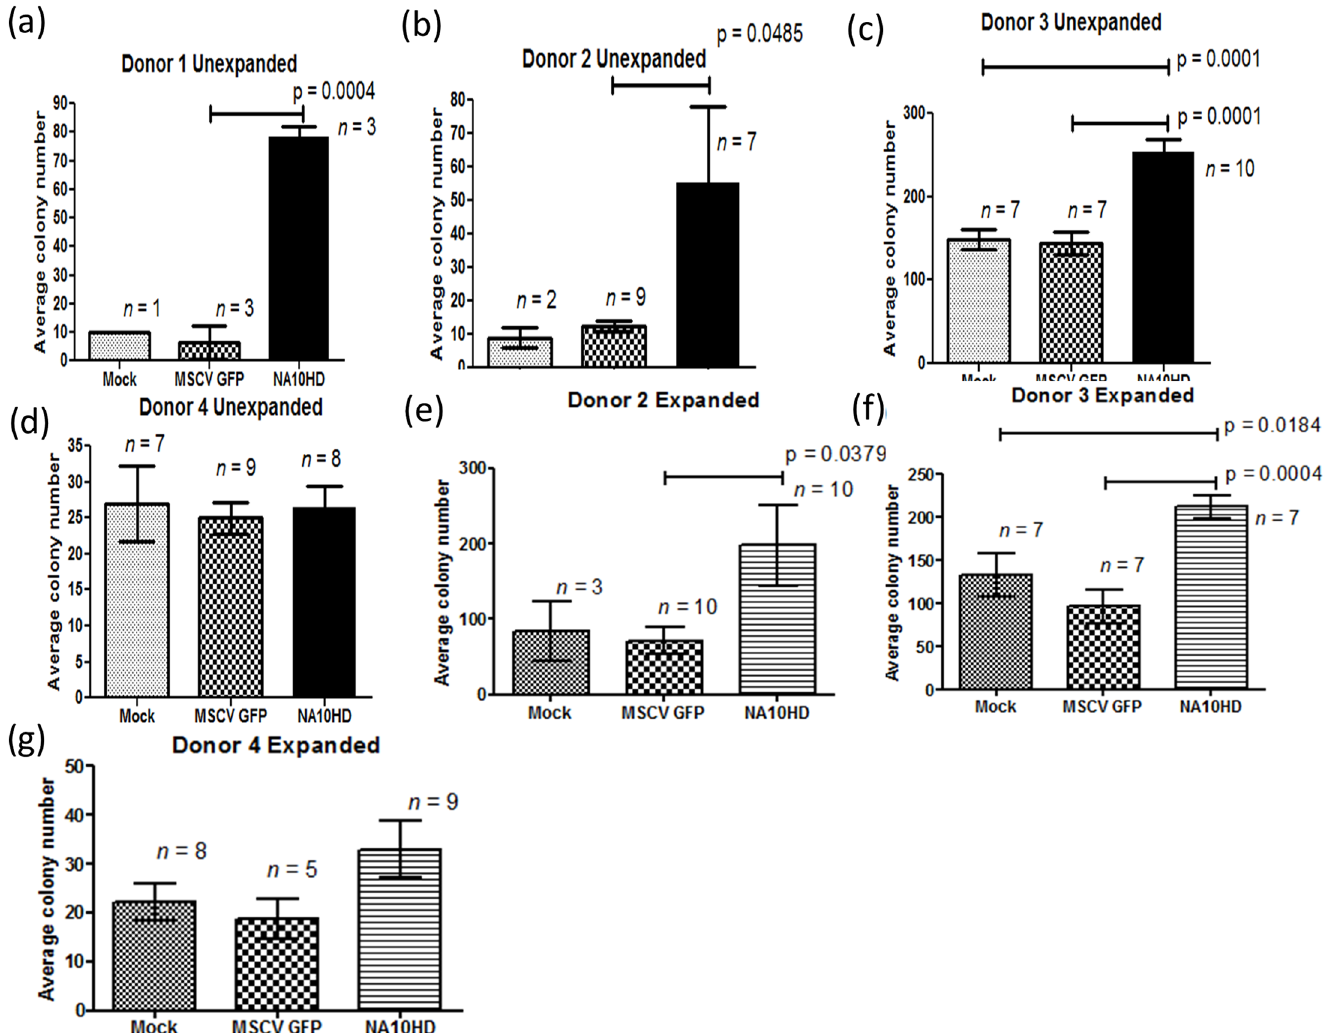
Fig 8. CFU-C assay of CD45+ engrafted cells recovered from bone marrow of NSG mice 12 – 15 week post transplantation with lentiviral transduced CD34+ cells. (a) – (d) Average colony numbers from four different human donors transplanted without expansion after transduction process. Donor 4 samples were inadvertently plated at one-third the intended number of cells per plate. (e)-(g) Average colony numbers from three different human donors transplanted after expansion in liquid culture for one week. Donor 4 samples were inadvertently plated at one-third the intended number of cells per plate. Donor 1 did not have sufficient CD34+ cells to perform the expanded cell experiments. Statistical comparisons performed using two-tailed upaired t-test with a p-value of 0.05 being considered